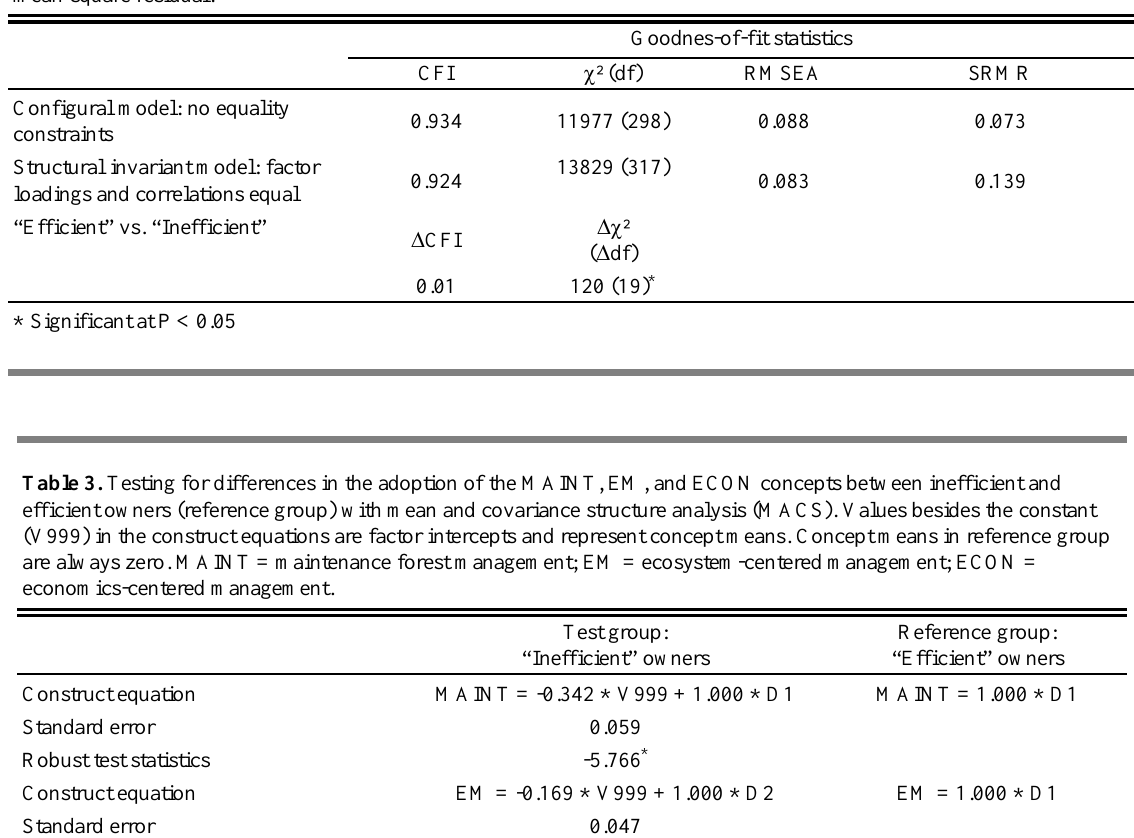
Table 2. Testing the invariance in the representation of forest management between efficient and inefficient forest owners. CFI = comparative fit index; RMSEA = root mean-squared error of approximation; SRMR = standardized root mean-square residual.